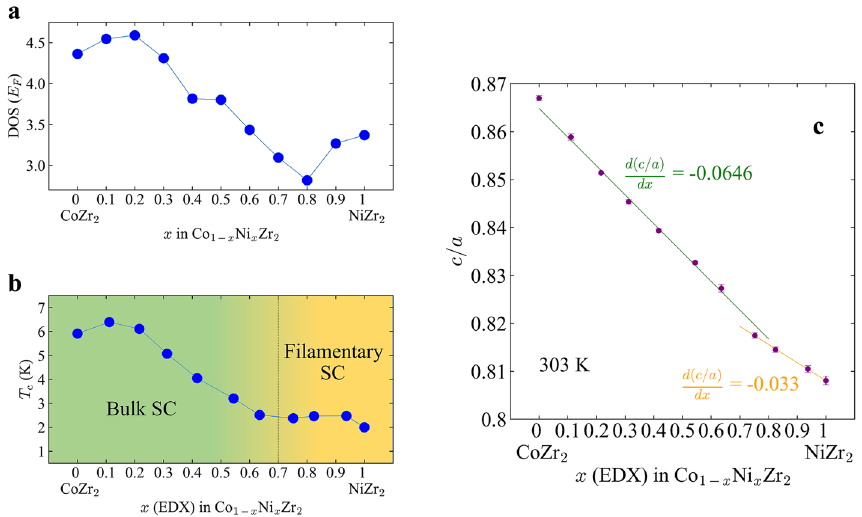
Figure 5. ( a ) The x dependence of DOS( E F ) for Co 1− x Ni x Zr 2 . ( b ) The x dependence of superconducting transition temperature for